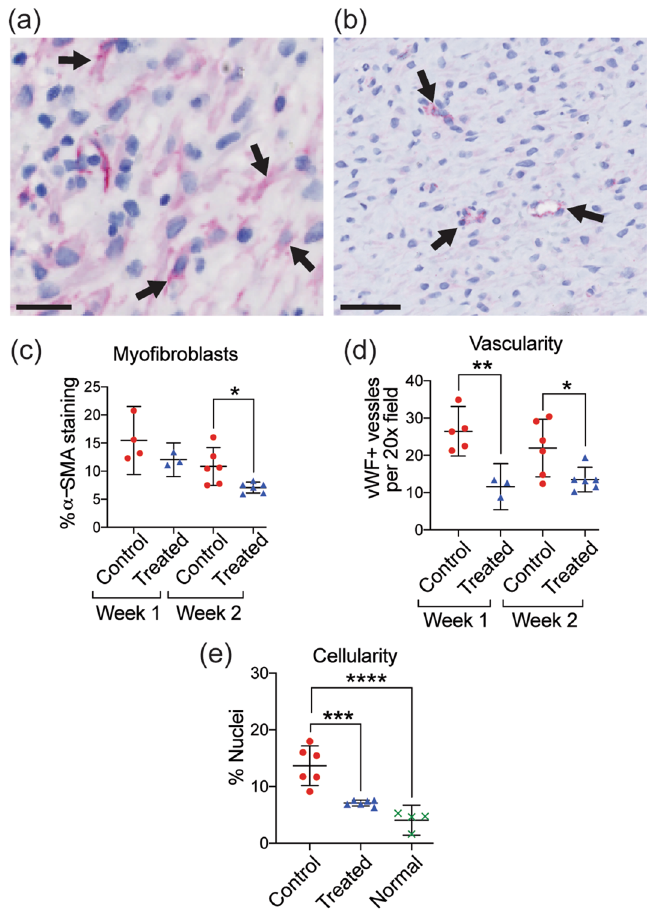
Figure 4. Reduction in myofibroblasts, vascularity, and dermal cellularity in MSTC-treated wounds. Representative images of immunohistochemical staining for α-smooth muscle actin ( a , myofibroblasts highlighted by arrows, scale bar = 25 μm) and von Willebrand factor ( b , vascular structures highlighted by arrows, scale bar = 50 μm). MSTC-treated wounds had reduced densities of α-SMA + myofibroblasts after 2 weeks ( c ), as well as vWF + blood vessels at both time points ( d ). Overall cellularity in the dermis was significantly elevated in control wounds at 2 weeks, compared to both MSTC-treated wounds and unwounded normal skin ( e ). *p ≤ 0.05, **p ≤ 0.005, ***p ≤ 0.0005, ****p ≤